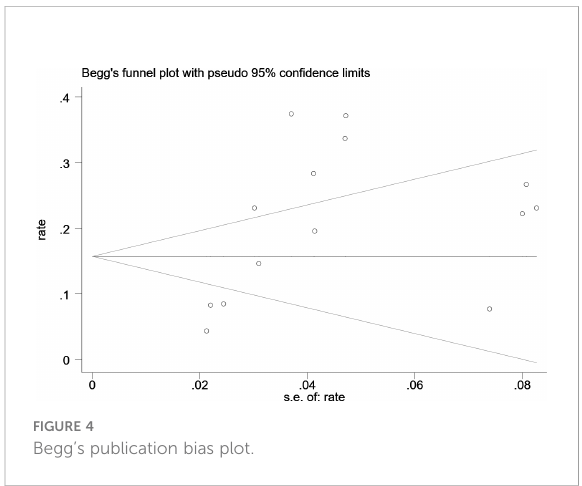
FIGURE 4 Begg ’ s publication bias plot.